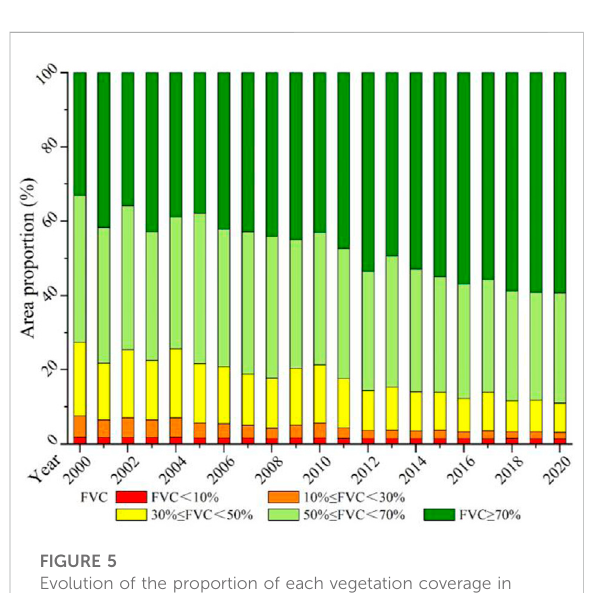
FIGURE 5 Evolution of the proportion of each vegetation coverage in the upper reaches of Ganjiang River Basin from 2000 to